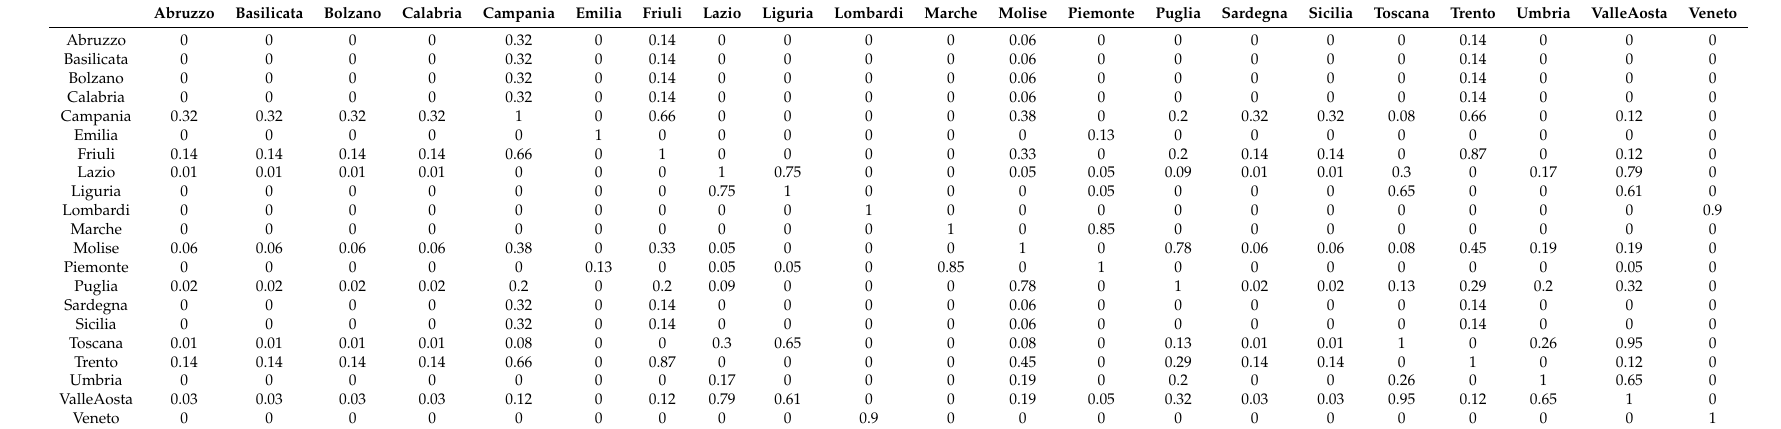
Table A9. Similarity values of Intensive Care network in the second week.